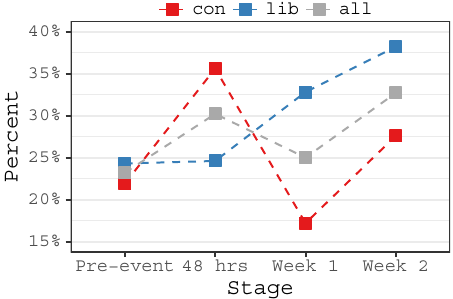
Fig. 4 The proportion of Moral Solution tweets throughout the shooting events. Each line represents the proportion of the group ’ s tweets that talked about Moral Solution across the different stages of